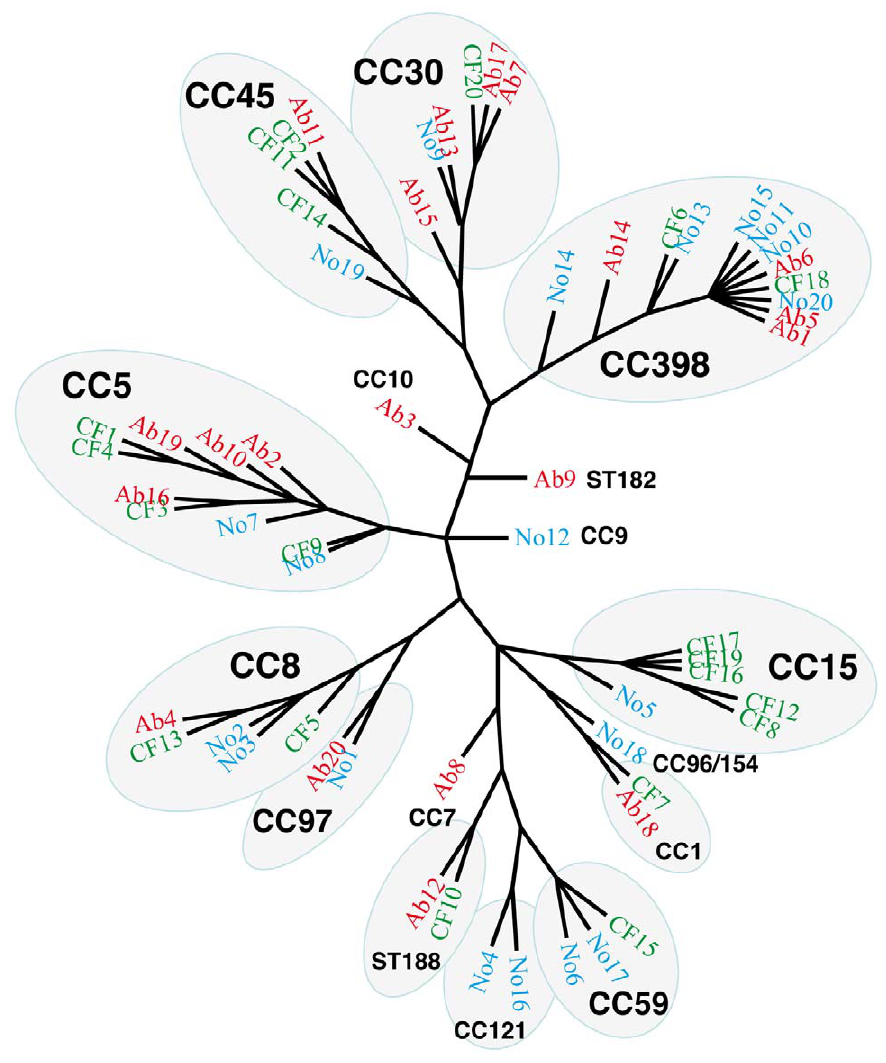
Figure 1. Split network tree constructed from the results of the microarray hybridization analysis of the 60 isolates. The tree was constructed using raw data from the microarrays to visualize the distribution of the strains among different Clonal Complexes. The strains were assigned the following numbers: Ab1 to Ab20 (in red), abscess strains; CF1 to CF20 (in green), cystic fibrosis sputa strains; No1 to No20 (in blue), nasal isolates. Multilocus sequence types (ST) and/or clonal complexes (CC) are indicated.